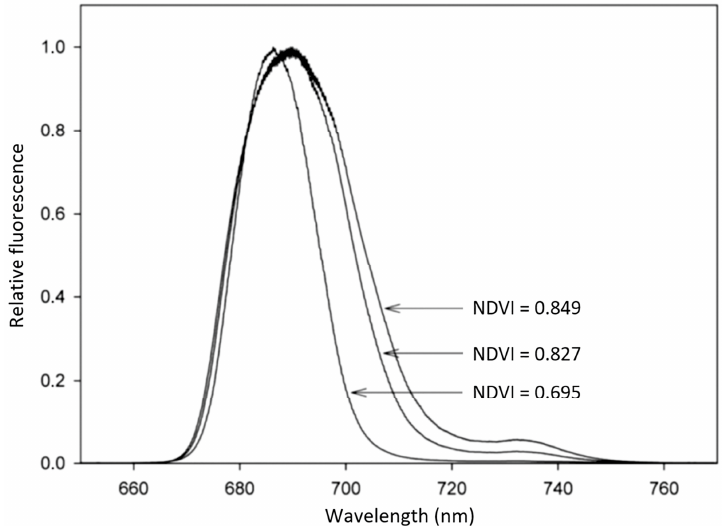
Figure 3. Relative fluorescence spectra of three samples of microphytobenthos (MPB) with different biomass in mud intertidal sediments (one sample with low biomass and two with high biomass). The normalized difference vegetation index (NDVI) is presented for the three samples (reprinted from Vieira [61] with permission).